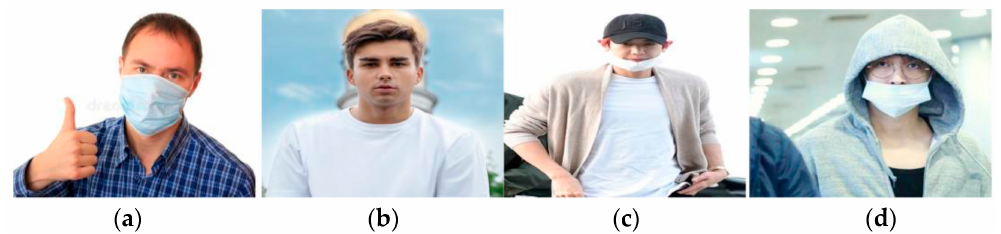
Figure 8. Dataset classification criteria. ( a ) Mask classification criteria. ( b ) Nomask classification criteria. ( c ) Poor classification criteria. ( d ) Poor classification criteria.